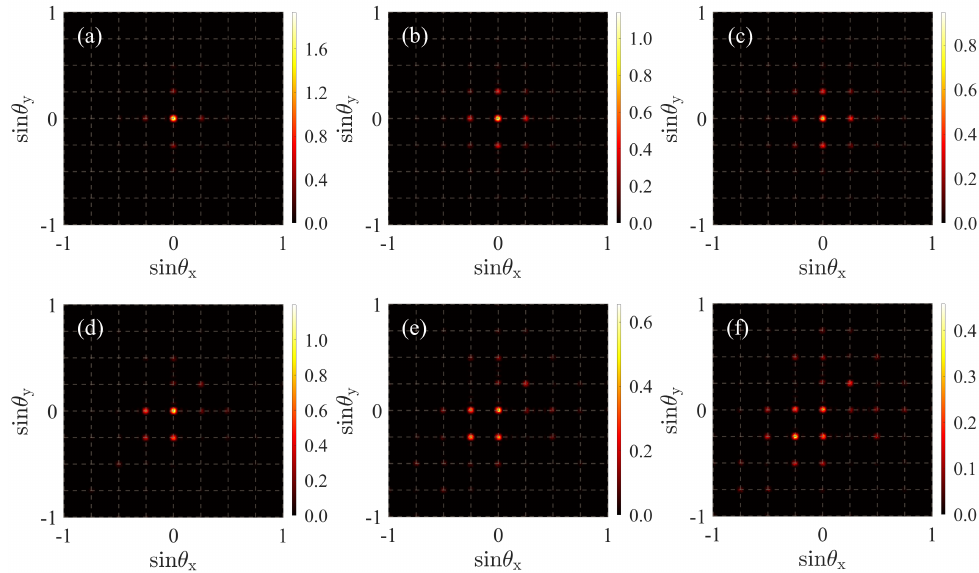
Figure 3. Fraunhofer diffraction intensity 10 I p plotted against sine functions of angles θ x and θ y . The upper panels are attained for δ ∆ c = 0 with ( a ) ∆ c 0 = 0 and N 0 = 2.5 × 10 10 cm − 3 ; ( b ) ∆ c 0 = Γ eg and N 0 = 2.5 × 10 10 cm − 3 ; ( c ) ∆ c 0 = Γ eg and N 0 = 4.0 × 10 10 cm − 3 . The lower panels are at- tained for ∆ c 0 = 0 and δ ∆ c = 2.0 Γ eg with ( d ) N 0 = 1.0 × 10 10 cm − 3 ; ( e ) N 0 = 2.5 × 10 10 cm − 3 ; ( f ) N 0 = 4.0 × 10 10 cm − 3 . Other parameters are the same as in Figure